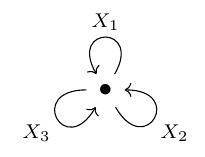
Figure 1 . Clover quiver diagram.